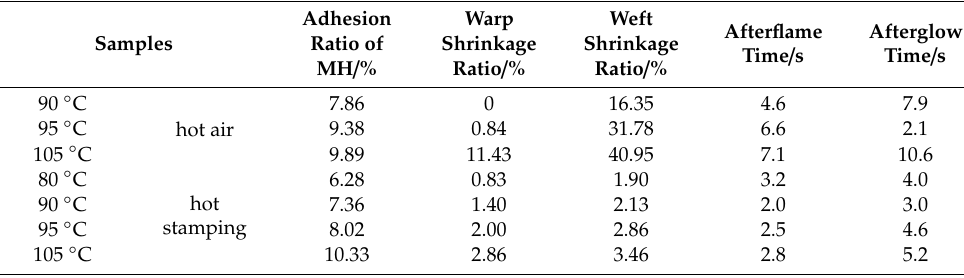
Table 2. The data of flame retardancy of CF / MH under di ff erent heating methods.